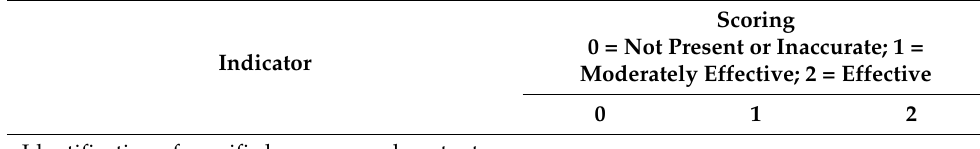
Table 1. Rubric for evaluating teacher-generated instructional materials.